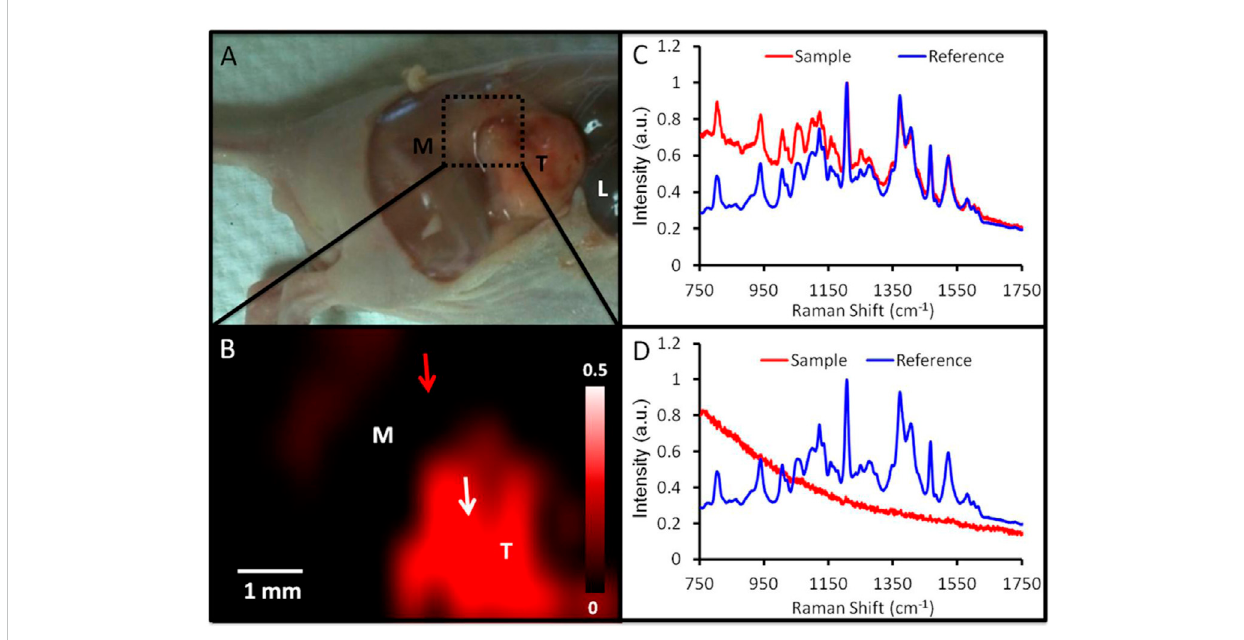
FIGURE 4 Identi fi cation of tumor margins using SERS imaging. (A) Image of a mouse carrying a 2008 tumor (T = tumor; M = muscle; L = liver) with the epidermis removed. The region depicted by SERS imaging 24 h after injection is denoted by a green box. (B) SERS imaging of the area denoted in panel A revealsanincreaseinSERSinthetumor(red).ThisSERSmapwasproducedbycorrelatingtheSERSspectraatvariousspatiallocations(redcurveinpanels C and D) to an ex vivo reference spectrum (blue curve in panels C and D). A close match between the reference and sample spectra (C) results in an intense pixel on the SERS map (tumor; white arrow, B). A dim pixel results from a poor match between the reference and sample spectra (D) (adjacent muscle; red arrow in B). Reproduce with permission frm ACS 2012 (Jokerst et al.,